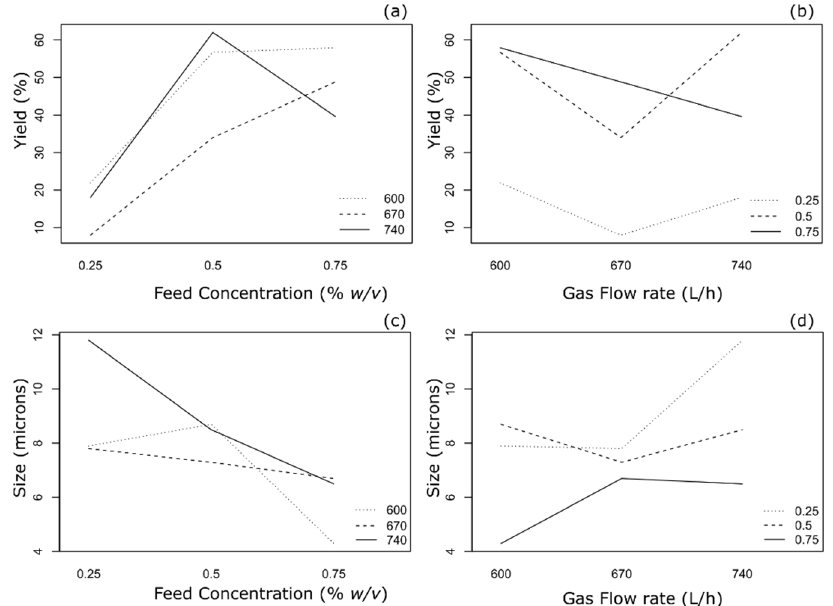
Figure 1. Main effects plots. ( a ) Effect of feed concentration on yield in different spray-gas flow rates. ( b ) Effect of spray-gas flow rate on yield in different feed concentrations. ( c ) Effect of feed concentration on particle size in different spray-gas flow rates. ( d ) Effect of spray-gas flow rate on particle size in different feed concentrations. Table 3. Cospray-dried powders of roflumilast (F1 to F9) with L-leucine and trehalose, their spray- drying yield, and particle size distribution.